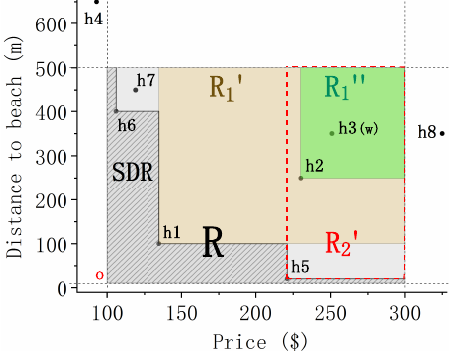
Figure 4. An example of the MRN